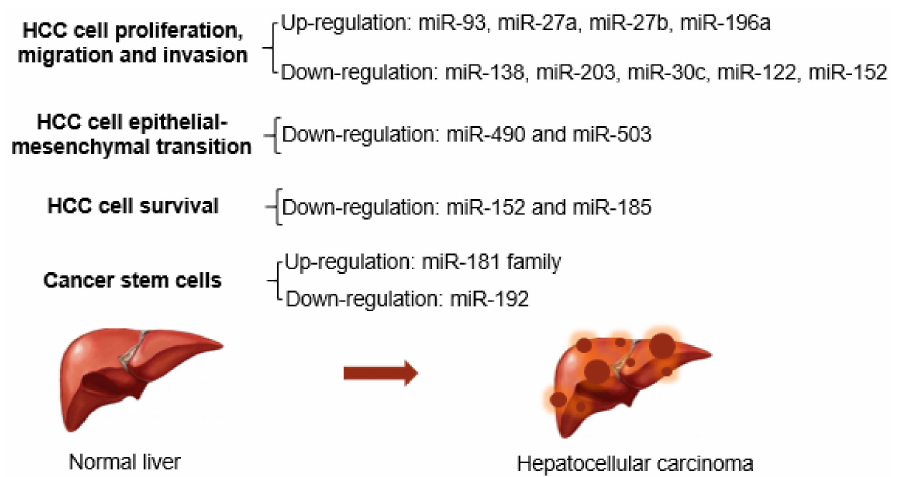
Figure 3. List of miRNA participating in cancerogenesis. HCV proteins regulated several miRNAs that are involved in multiple oncogenic